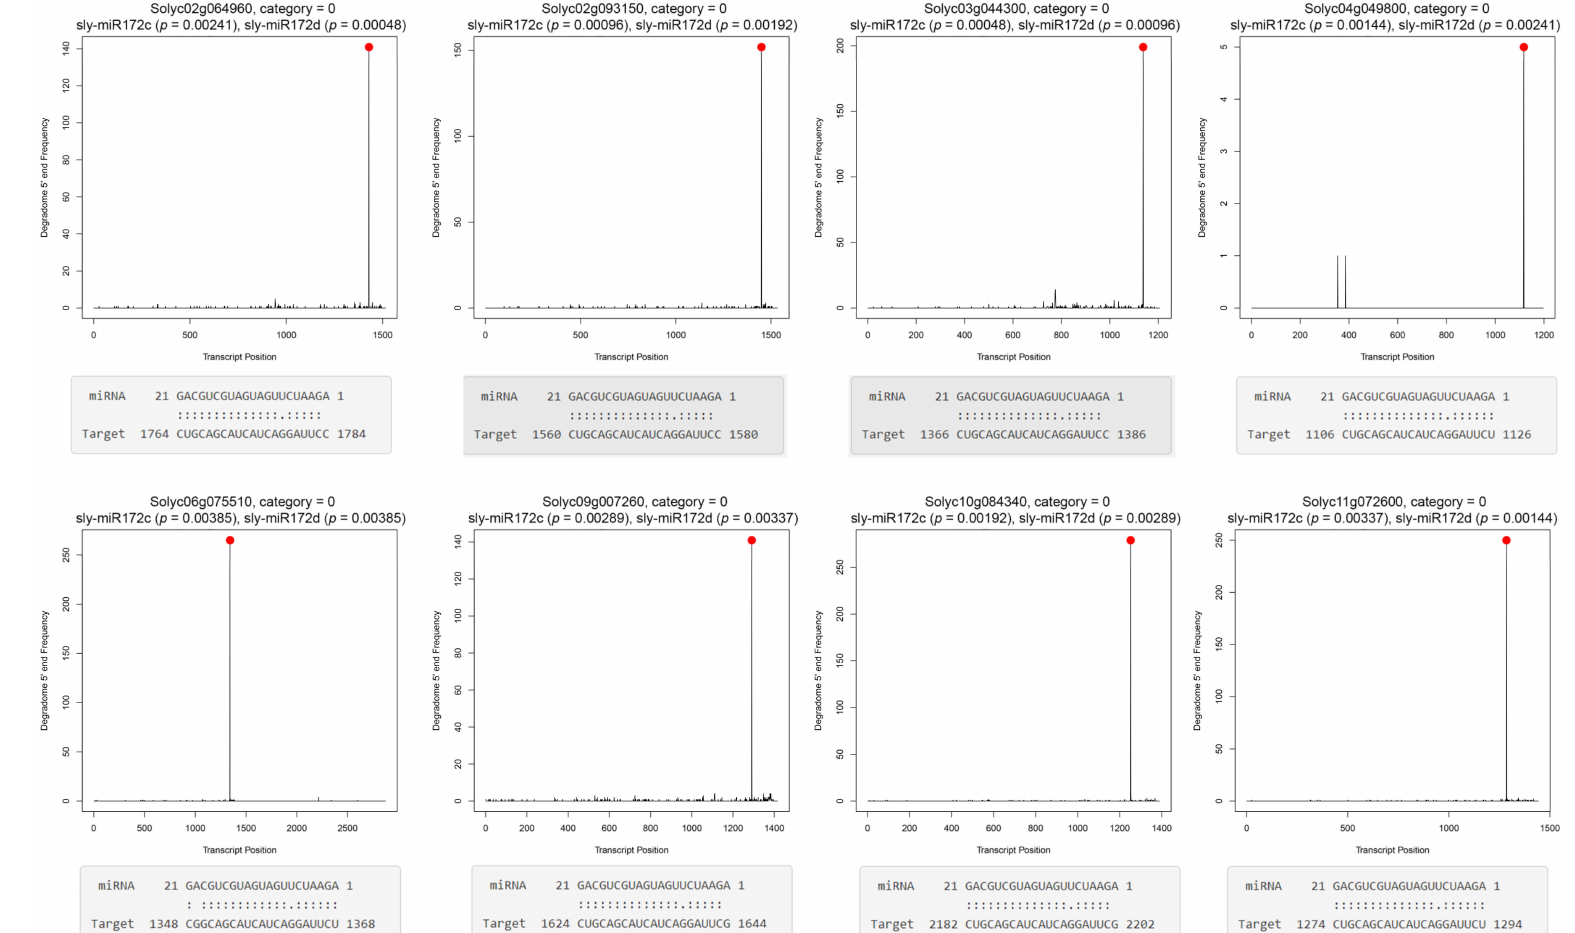
Figure 6. mRNAs predicted to be guided to cleavage by sly-miR172c and sly-miR172d in the flower. Target plots of sly-miR172c and sly-miR172d target mRNAs. The plots are identical for both miRNAs except for the indicated p -value. Peaks of reads that their 5 (cid:48) end is at the predicted cleavage site of sly-miR172c and sly-miR172d are indicated by red circles. Below each plot, Watson-Crick pairing between indicated target sequence and sly-miR172c as predicted by psRNATarget. Similar parings were predicted also for sly-miR172d except for its 5 (cid:48) nucleotide that is